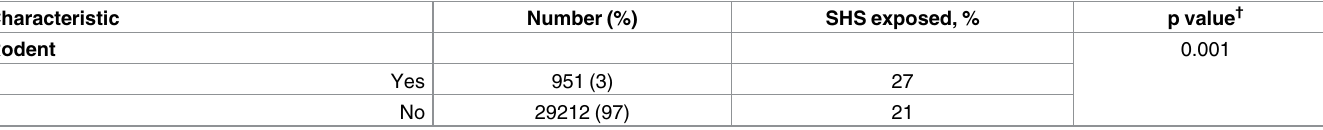
asthma as compared to intermittent asthma (S1 Table). Black race, Hispanic/non-Puerto Rican and Puerto Rican ethnicity were also significant predictors of persistent asthma. Chil- dren who resided in the urban core experienced the highest risk for persistent asthma. Other risk factors for greater asthma severity included positive family history of asthma, Medicaid insurance, eczema, exposure to cockroaches, and gas stoves (S1 Table). In adjusted models, exposure to SHS remained a significant risk factor for mild and moderate persistent asthma (Table 4). Race/ethnicity remained an overall significant predictor of persistent asthma, with Black, Puerto Rican, and Hispanic/ non-Puerto Rican children at higher risk for moderate per- sistent asthma than Caucasians. Area of residence remained an overall significant predictor of persistent asthma, with children living in the urban core, urban periphery, and rural areas at higher risk for moderate persistent asthma than children living in suburban/wealthy areas. Children with Medicaid experienced a greater risk for mild and moderate persistent asthma than children with private insurance. Pairwise absolute correlations of risk factors greater than 0.5 are reported (see S7 Table). The highest correlation was reported for Caucasian (1 = Cauca- sian, 0 = otherwise) and Area of Residence at 0.75. However, the information matrix showed no evidence of ill-conditioning as the largest condition index was only 3.33.